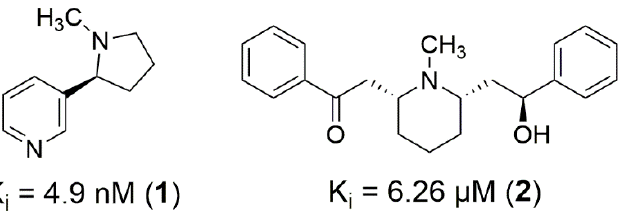
Figure 1. 2D structures of nicotine ( 1 ) and lobeline ( 2 ), followed by K i values for ( α 4) 2 ( β 2) 3 and α 7 nAChRs subtypes, respectively.